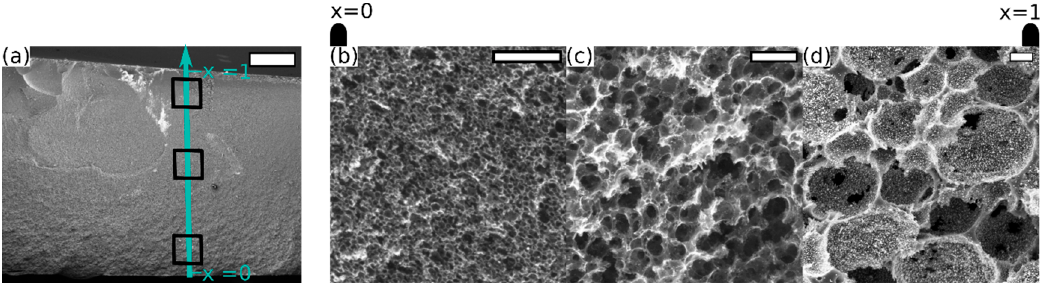
Figure 2. Analysis of a gradient porous Mag@C material by SEM. ( a ) SEM micrograph of the cross-section, showing the monolithic structure (scale bar: 200 μ m), with rectangles indicating scanning positions, and arrow indicating direction of the centrifugal force with the internal coordinate x. ( b – d ) Enlarged SEM images (scale bar: 1000 nm) taken along the direction of the centrifugal force; positions according to the squares in ( a ).